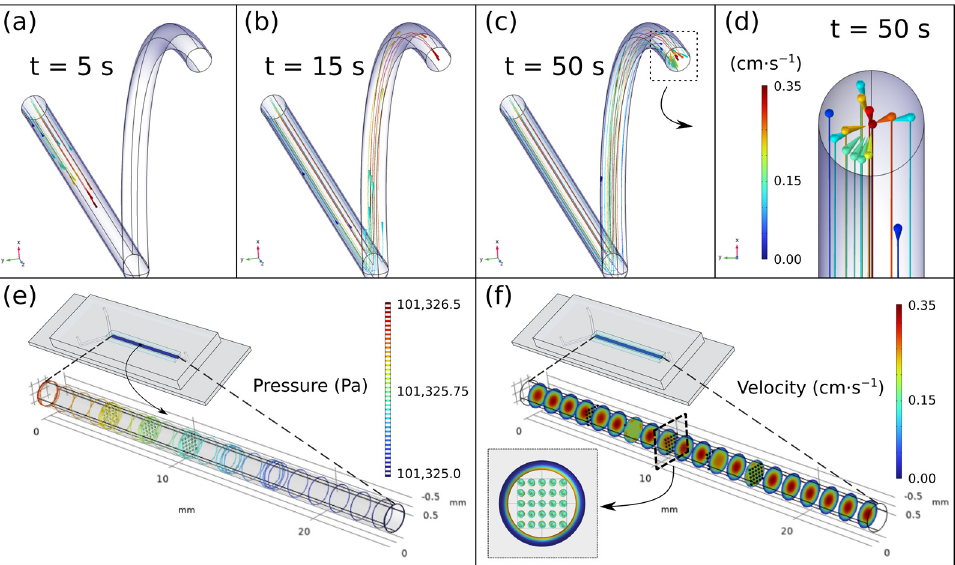
Figure 2. From ( a – c ). Particle position at different time points. Each particle describes equidistant trajectories. ( d ) Close-up of the end of the output tube. ( e , f ) Pressure and velocity simulations of the inlet channel assuming a grid of 25 elements on each panel. Results confirm that the presence of a small solid dragged by the flow does not affect the homogeneity.